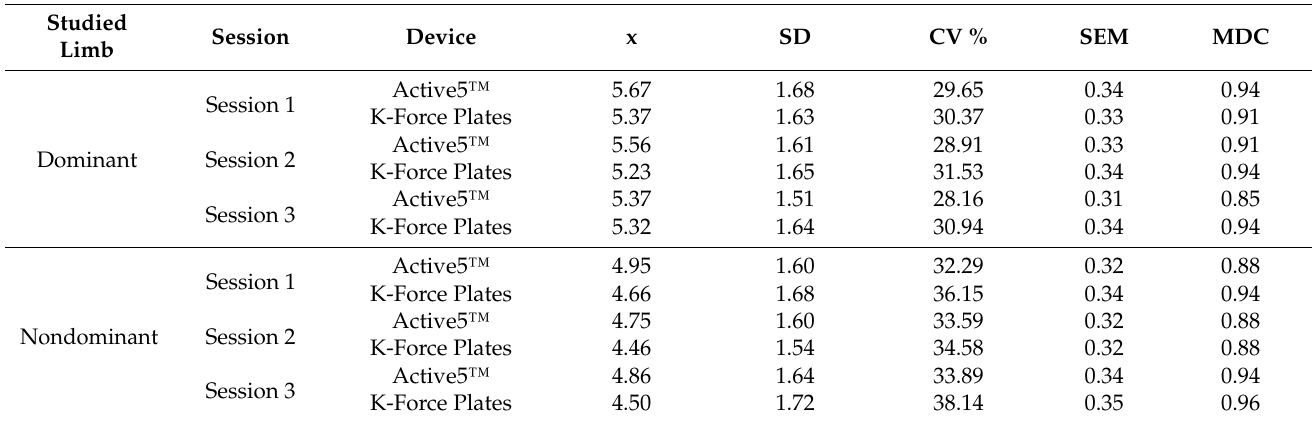
Table 4. The results of force measurements at 180 ◦ shoulder abduction using Active5™ and K- Force